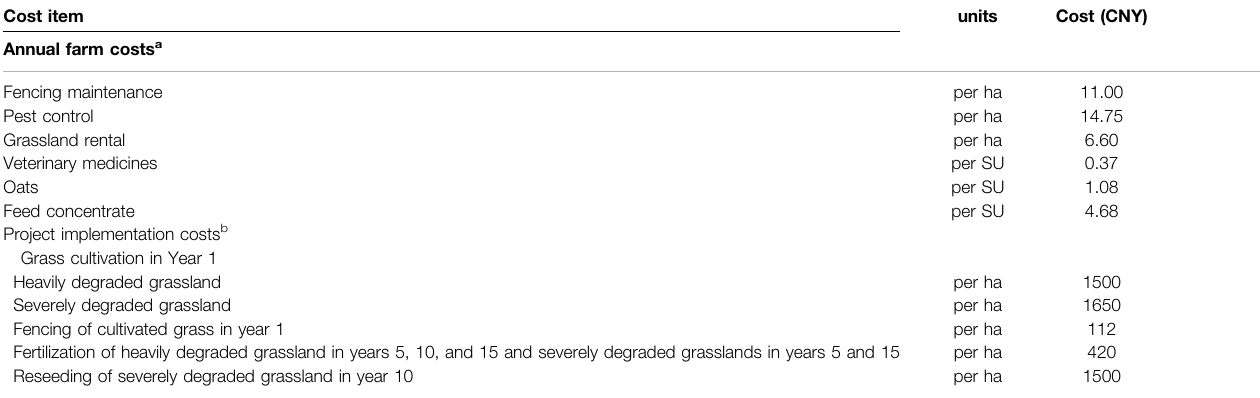
TABLE 2 | Cost parameter values applied in estimation of net income of the household in the scenarios modeled. Cost item